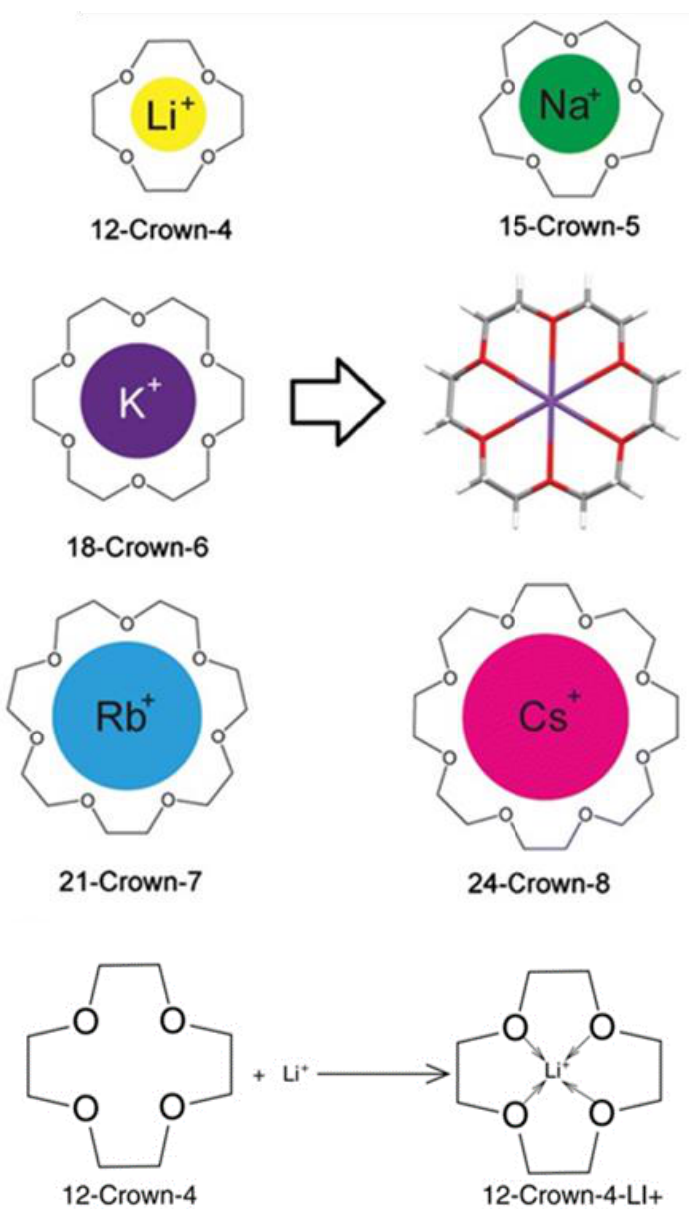
Figure 15. Structure of alkali cations with crown ether (top) and lithium complexation with crown ether (bottom) [181]. Reproduced with permission from Wiley. Swain, B. (2016), Separation and purification of lithium by solvent extraction and supported liquid membrane, analysis of their mechanism: a review. J. Chem. Technol. Biotechnol., 91: 2549–2562. https://doi.org/10.1002/jctb.4976, accessed on 1 September